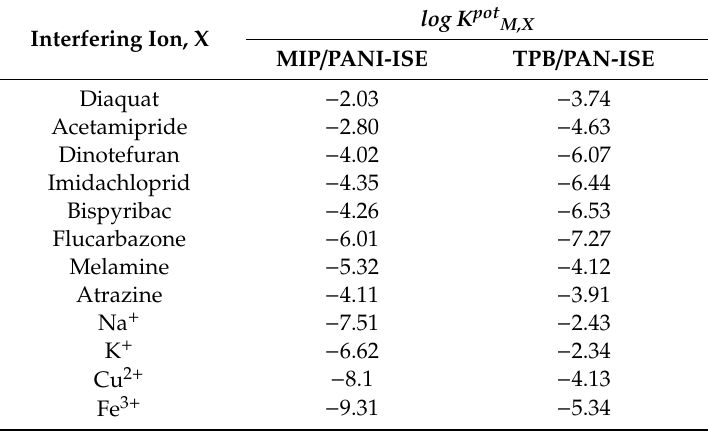
Table 2. Potentiometric selectivity coe ffi cients ( logk pot DOP in 50 mM acetate solution of pH 3.5.